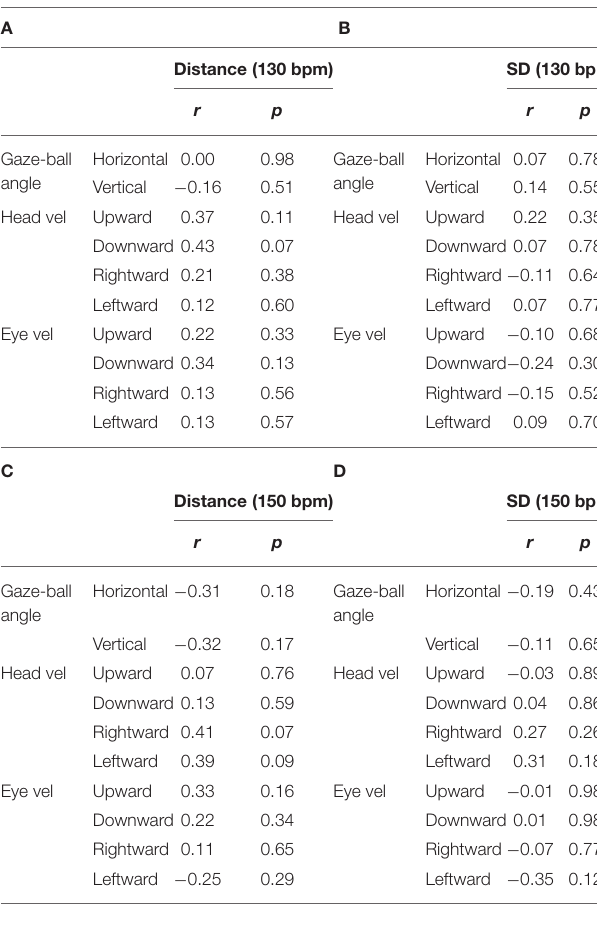
to calculate the coordinates (pixel) of the ball and gaze position. After the digitizing process, the gaze position coordinates were subtracted from ball position coordinates to estimate the gaze- ball angle ( Figure 1B ). Finally, the pixel values of the coordinates were converted to angles based on the specifications of the eye- tracking device (horizontal angle: 82 deg/1920 px, vertical angle: 52 deg/1080 px). Through these processes, we obtained both the horizontal (Gaze-Ball Angle X) and vertical angles (Gaze-Ball Angle Y). Figure 2 shows a typical pattern of the gaze-ball angles in a single rally. These angles at the time the ball bounces (solid black line) were significantly different between the experts (blue) and semi-experts (red) players. Thus, we averaged the gaze-ball angle for three frames (pre-bounce, bounce, post-bounce). The gaze-ball angle was calculated as the mean absolute value for each participant. The mean angular velocities of the pitch (downward and upward) and yaw (rightward and leftward) movements were calculated to evaluate the head movement during the rallies. At the same time, the mean angular velocities of the vertical (downward and upward) and horizontal (rightward and leftward) eye movements were calculated to evaluate the